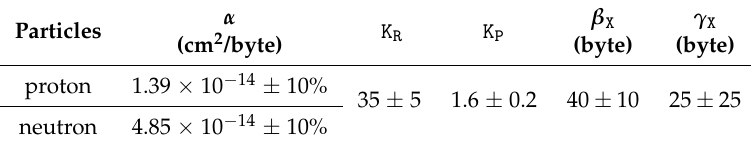
Table 5. ARM Cortex-A9 parameters estimated during two radiation campaigns.